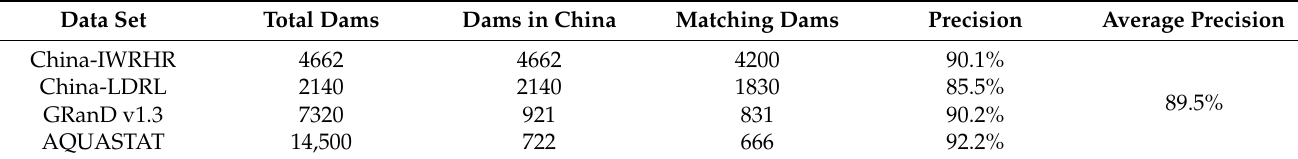
Table 2. Comparison and verification of China ’ s artificial water body data and other dam location data sources in 2020.